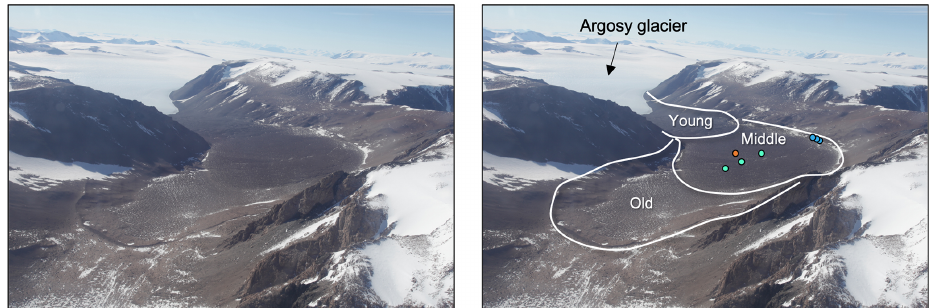
Figure 2. Oblique aerial photograph of Ong Valley (left) with added markings (right) indicating the Young, Middle, and Old drifts (Bibby et al., 2016). The photograph is looking northward and down-valley. The dots represent the sampling sites as identified in Fig.